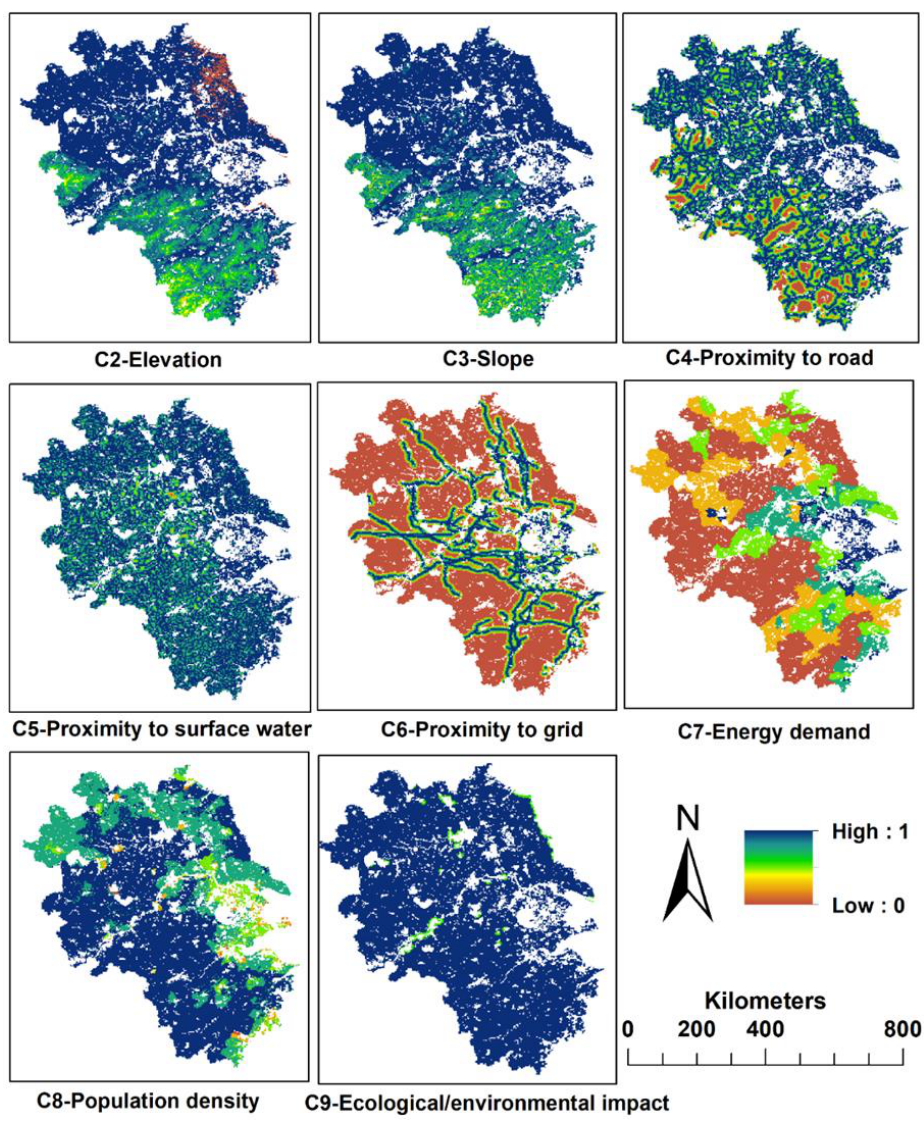
Figure 6. Spatial suitability map of evaluation criteria (C2 – C9).